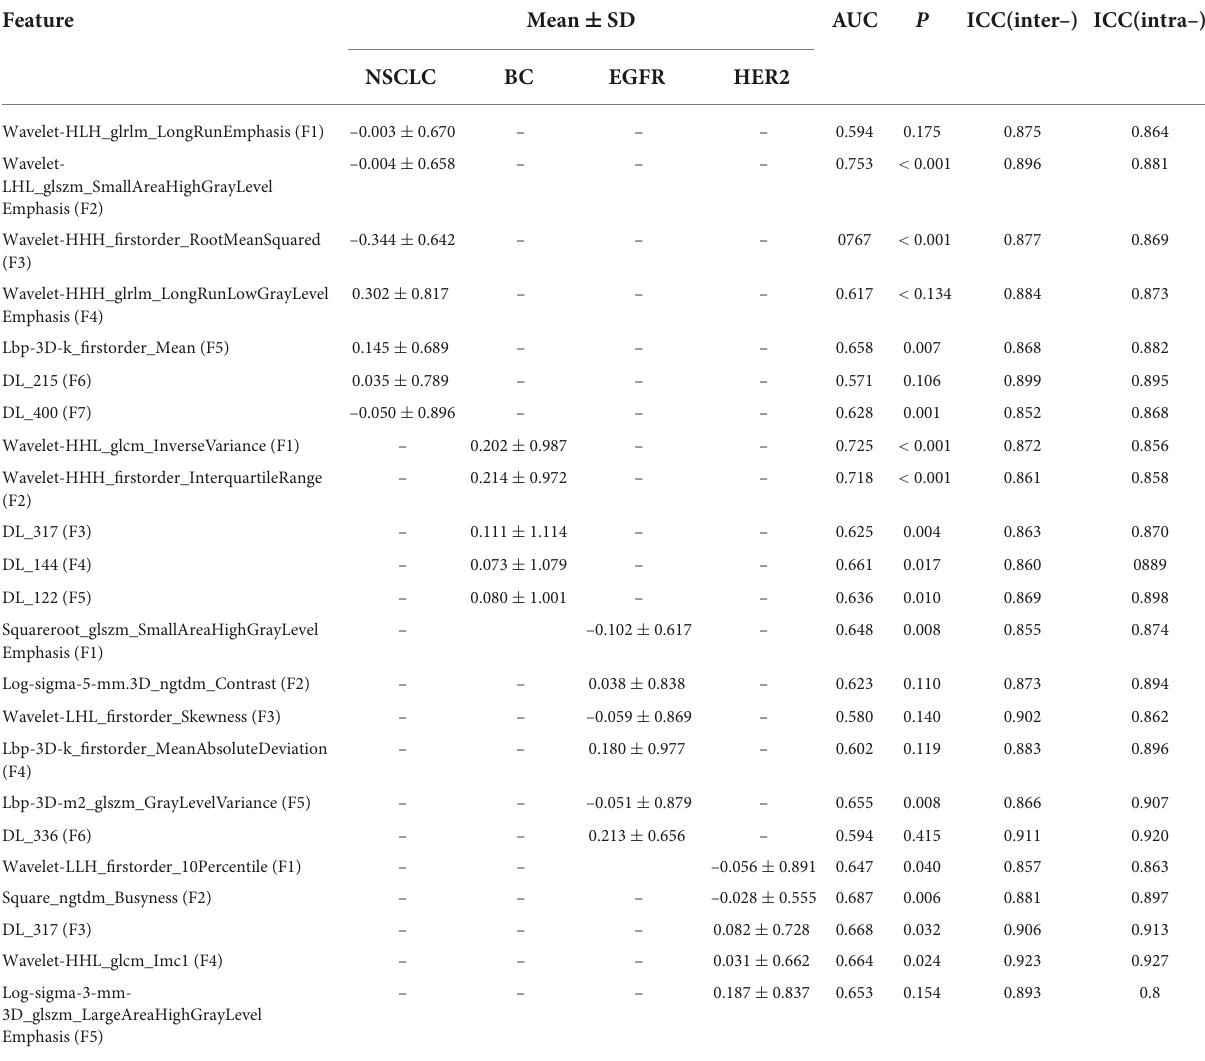
TABLE 4 Prediction performance of the selected